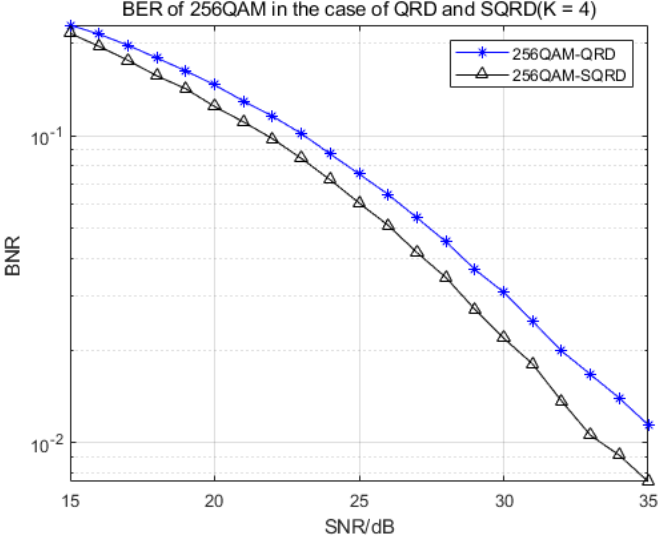
Figure 6. BER of 256-QAM demodulation in the case of QRD and SQRD (K =